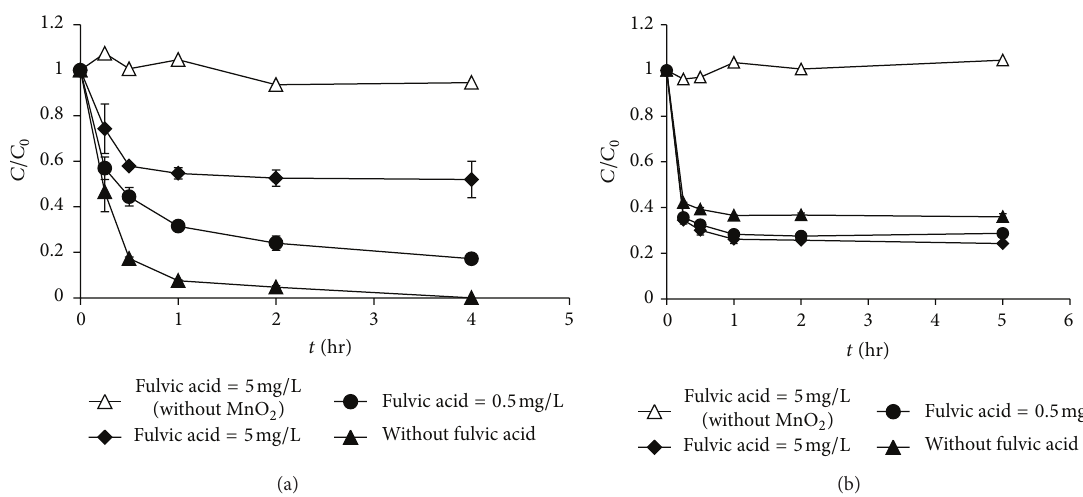
Figure 7: Effect of fulvic acid on the oxidation of (a) morphine (with 100 𝜇 g/L MnO 2 ) and (b) codeine (with 8 mg/L MnO 2 ) (compound concentration = 100 𝜇 g/L, pH = 7, and ionic strength = 10 mM).